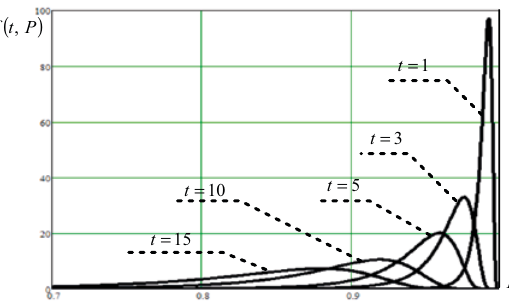
Fig. 3. Nomograms for the PDF of no failure operation in a finite time